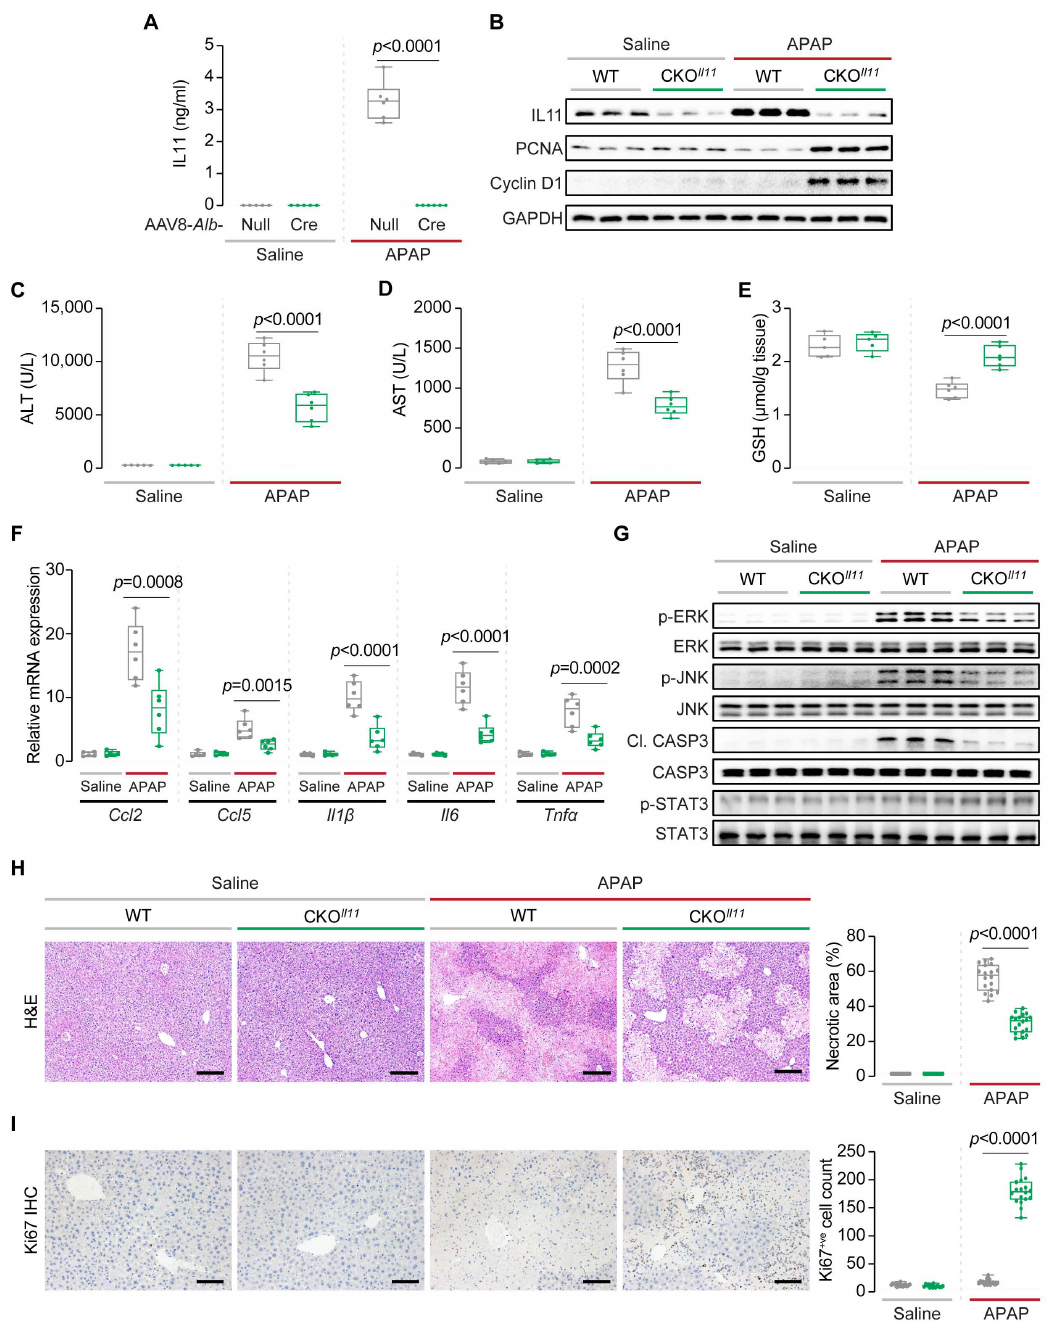
Figure 6. Hepatocyte-specific deletion of Il11 reduces APAP-induced liver injury and promotes hepatic regeneration 24 h after injury. ( A ) Serum IL11 levels, ( B ) Western blots showing hepatic levels of IL11, PCNA, Cyclin D1, and GAPDH as the internal control ( n = 3/group), ( C ) serum ALT levels, ( D ) serum AST levels, ( E ) hepatic GSH levels, ( F ) hepatic mRNA expression of pro-inflammatory markers ( Ccl2 , Ccl5 , Il1 β , Il6 , Tnf α ), ( G ) Western blots showing hepatic levels of p-ERK, ERK, p-JNK, JNK, Cl. CASP3, CASP3, p-STAT3, and STAT3 ( n = 3/group), ( H ) representative H&E-stained liver images (scale bars, 200 µ m) and quantification of the liver necrotic area, ( I ) IHC staining of Ki67 in the livers of mice (scale bars, 200 µ m) and quantification of Ki67 +ve cells for experiments shown in Figure 5B. ( A , C – F , H , I ) Saline ( n = 5 mice/genotype), APAP ( n = 6 mice/genotype); data are shown in a box-and-whisker plot with median (middle line), 25th–75th percentiles (box), and min-max values (whiskers), with a 2-way ANOVA with Sidak’s